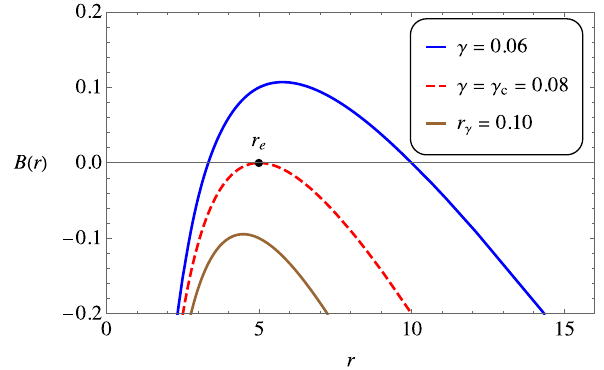
Fig. 1 Plotofthelapsefunctionfordifferentvaluesofthe γ parameter. For this diagram and all the forthcoming ones, we have considered α = 0 . 2, and the unit of length along the axes is M . This way, the extremal horizon will be located at r e =